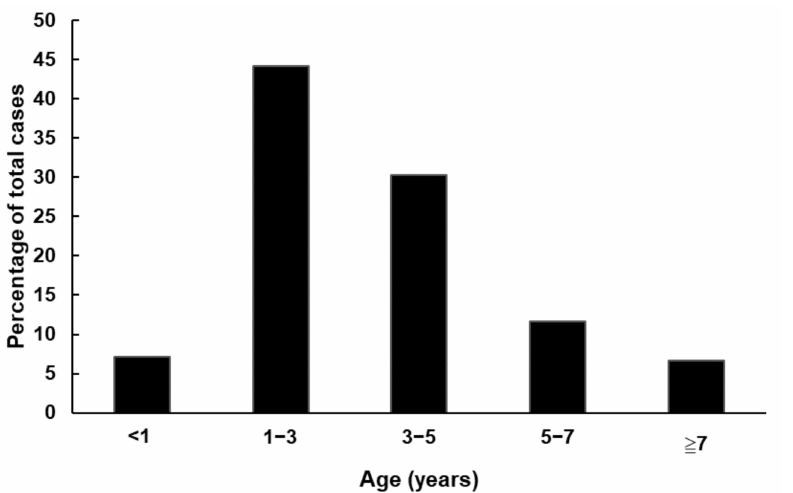
Figure 2. Age distribution of the patients infected with CVA16. The percentage of CVA16 infected cases in each group to total CVA16 cases was calculated and shown as column. The incidences of each group were listed as follows: 7.2% under 1 year old, 44.2% between 1 and 3 years old, 30.3% between 3 and 5 years old, 11.7% between 5 and 7 years old, and 6.6% more than 7 years